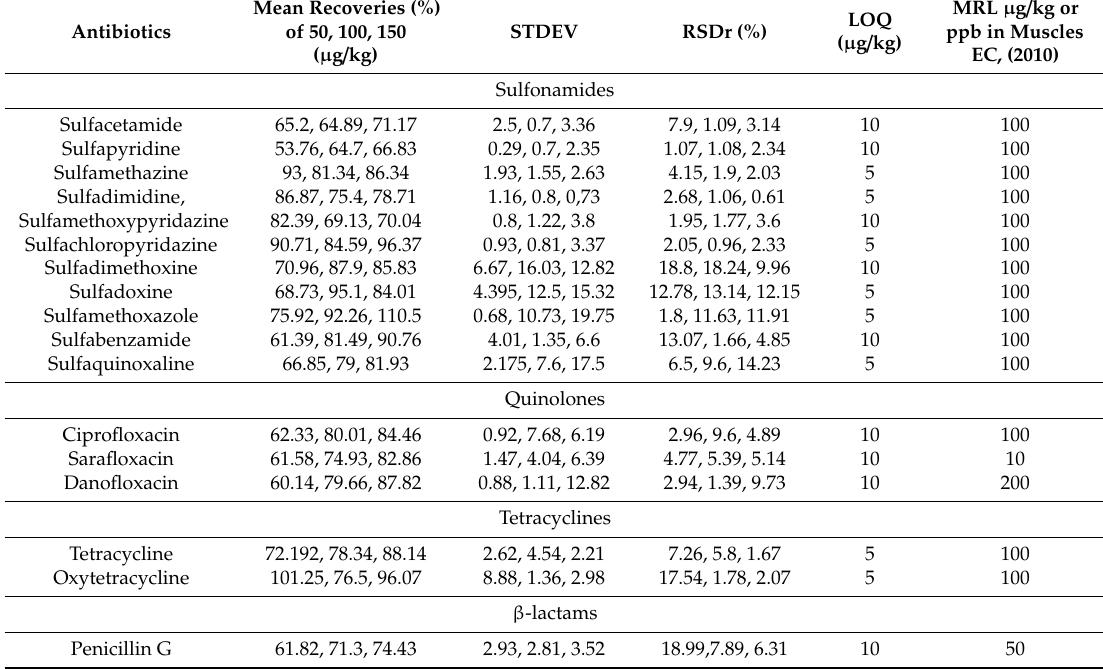
Table 2. Results of in-house validation of the LC–MS / MS method for the antibiotics considered in this study, with the maximum residue limits (MRLs) established by the European Union (2010) [8]. STDEV: standard deviation. RSDr: relative standard deviation of repeatability. LOQ: limit of quantification.